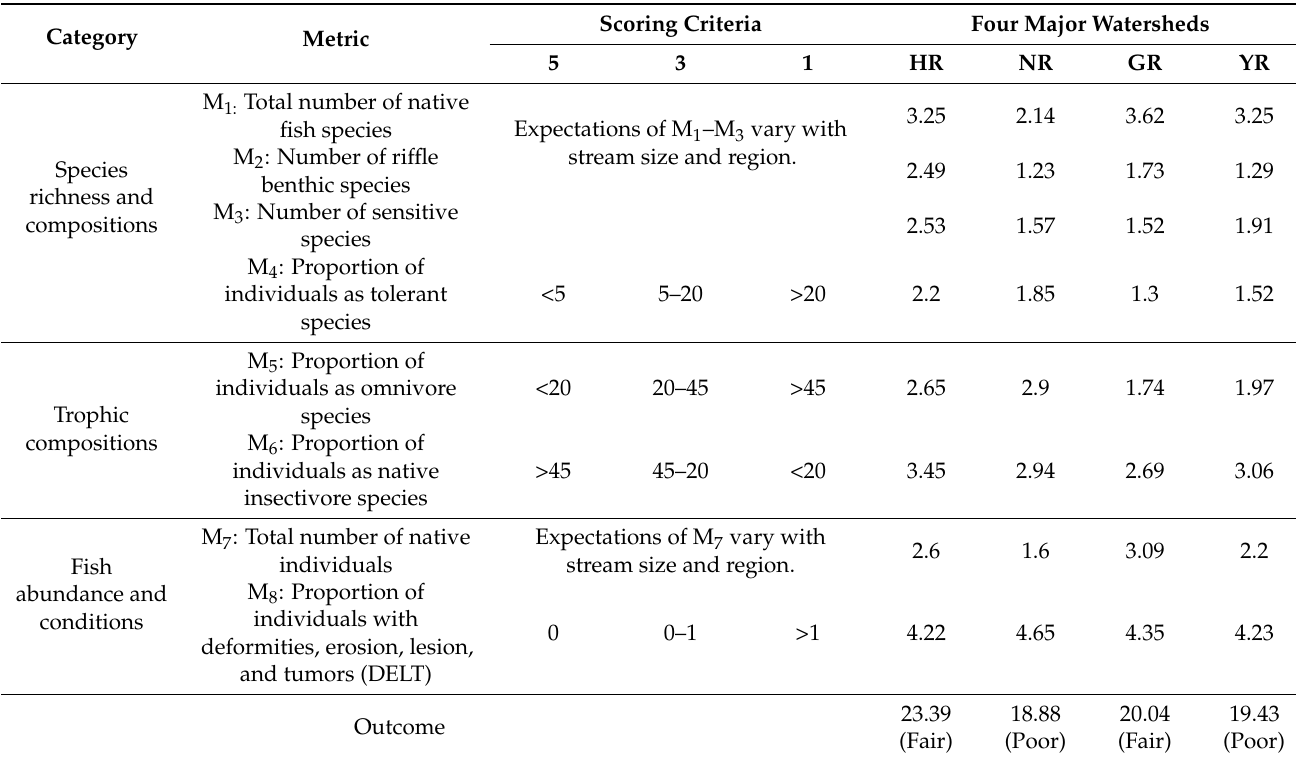
Table 4. Ecological health assessment based on the index of biotic integrity (IBI) in the four major rivers watersheds during 2008–2009. HR = Han River, NR = Nakdong River, GR = Geum River, Y/SR = Yeongsan/Seomjin Rivers. Scoring Criteria Four Major Category Metric